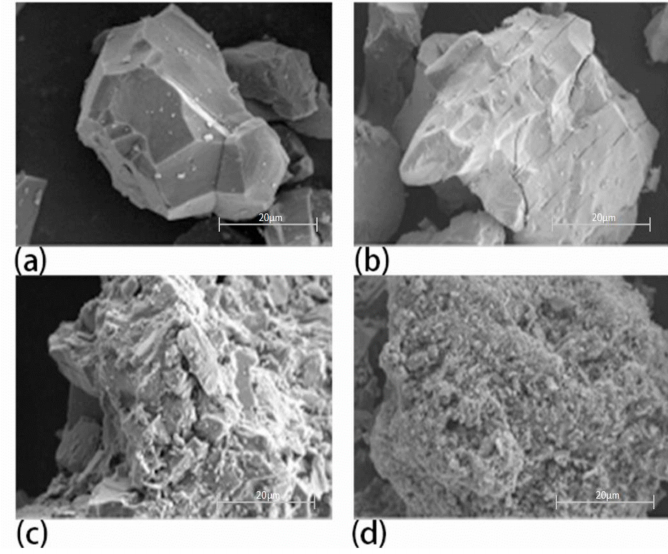
Figure 11. SEM images of rare earth concentrate: ( a ) sample 1, ( b ) sample 2, ( c ) sample 3, and ( d ) sample 4.